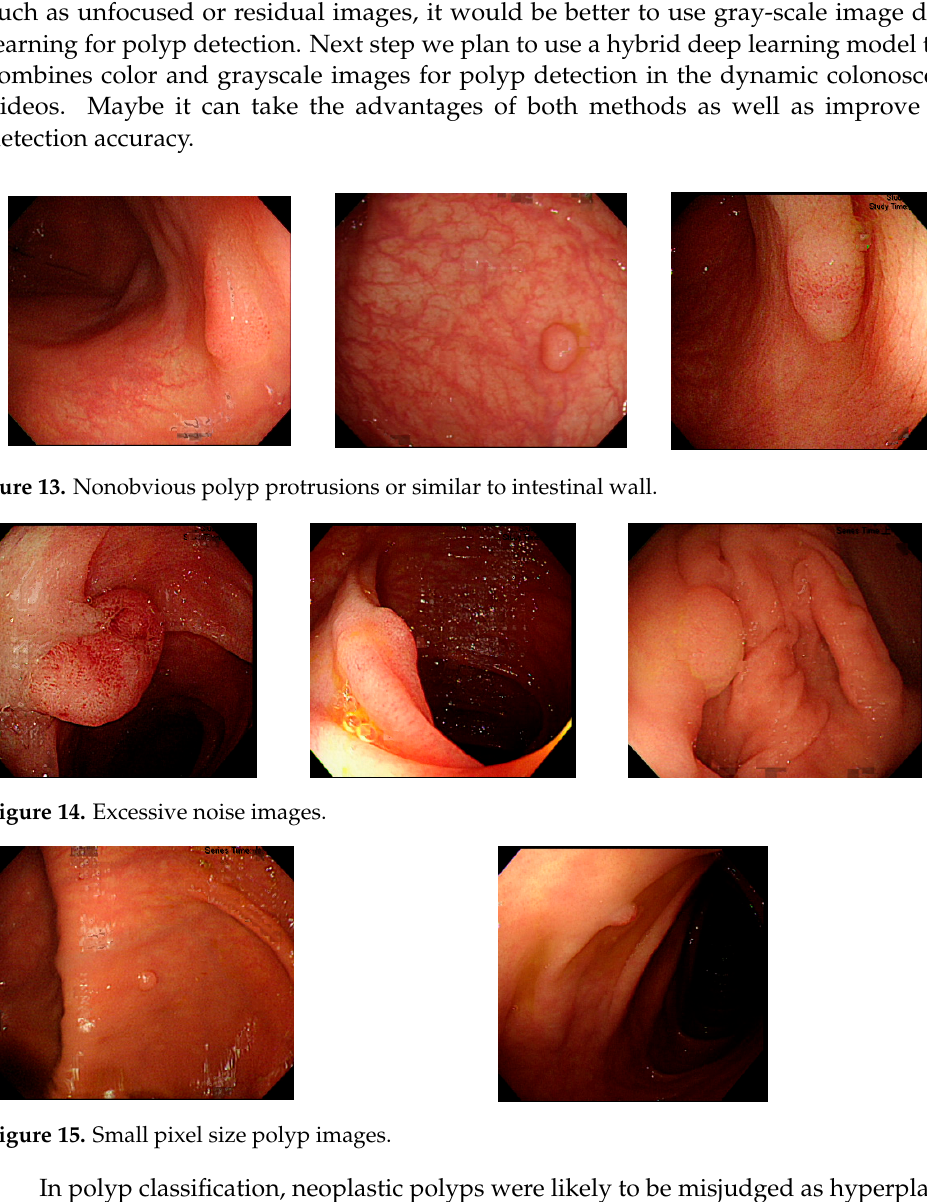
20 Table 18. Confusion matrix of NBI polyp classification. Neoplastic (Predicted) Hyperplastic (Predicted) Neoplastic(Actual) 31 Table 19. Performance index of polyp classification. Acc%